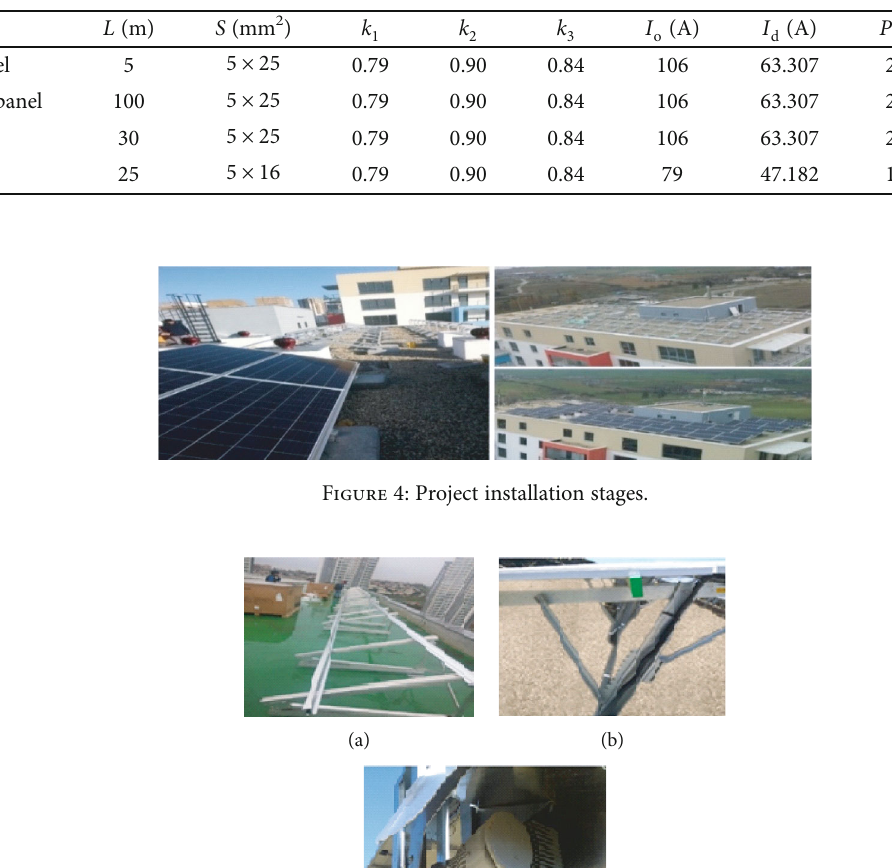
Table 2: Calculations for the AC voltage drop, power dissipation, and current.